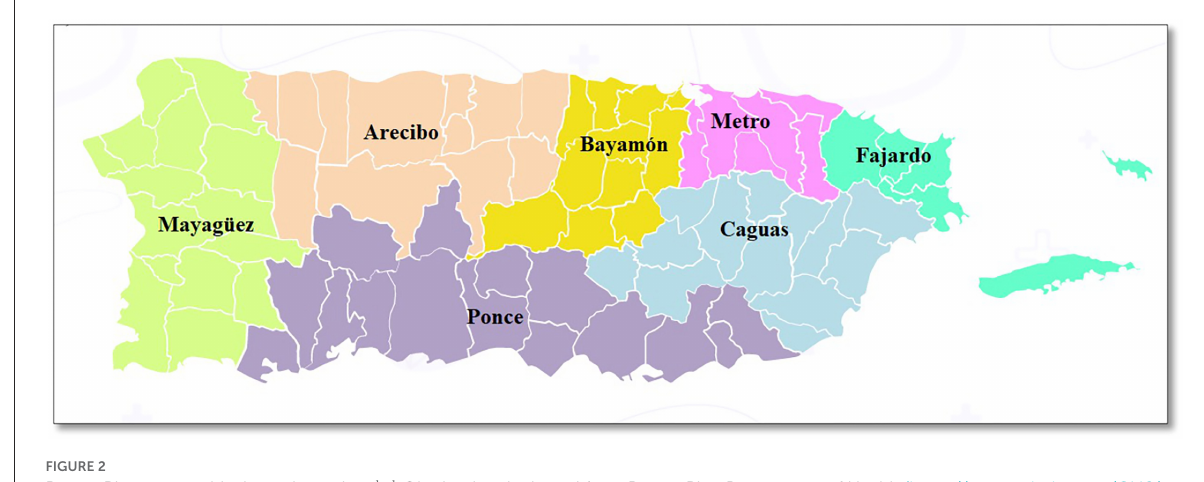
FIGURE2 Puerto Rico geographical map by regions 1 . 1 Obtained and adapted from Puerto Rico Department of Health (https://www.salud.gov.pr/CMS/